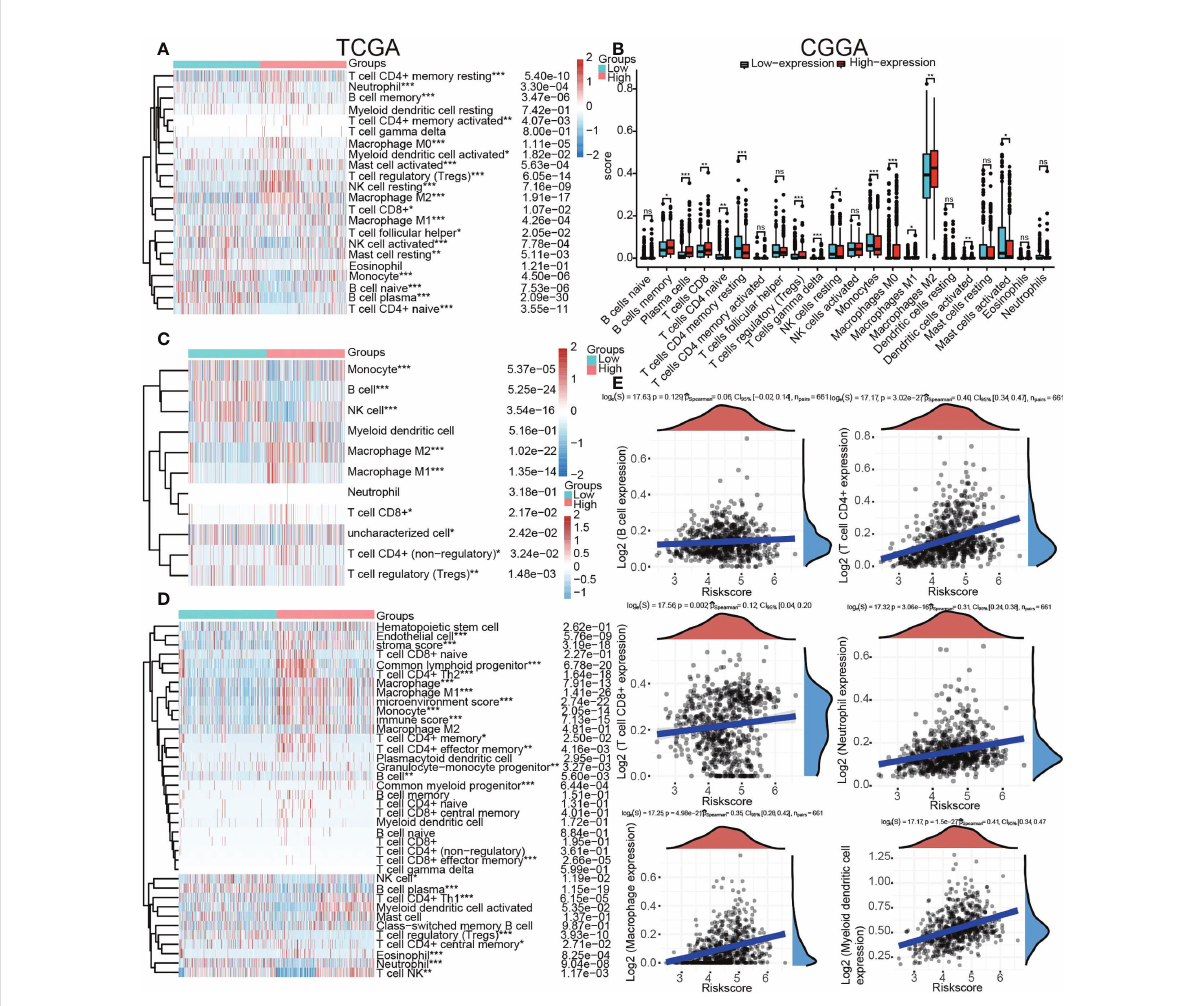
FIGURE 9 Relationships between TP53I13 expression and different tumor immune lymphocytes (A) using the CIBERSORT algorithm on samples obtained from TCGA database, (B) using the CIBERSORT algorithm on samples obtained from CGGA database, (C) using the quanTiseq algorithm on samples obtained from on TCGA database, (D) by using the xCell algorithm on samples obtained from on TCGA database, and (E) by using the TIMER algorithm on samples obtained from on TCGA database. *P < 0.05, **P < 0.01, ***P <